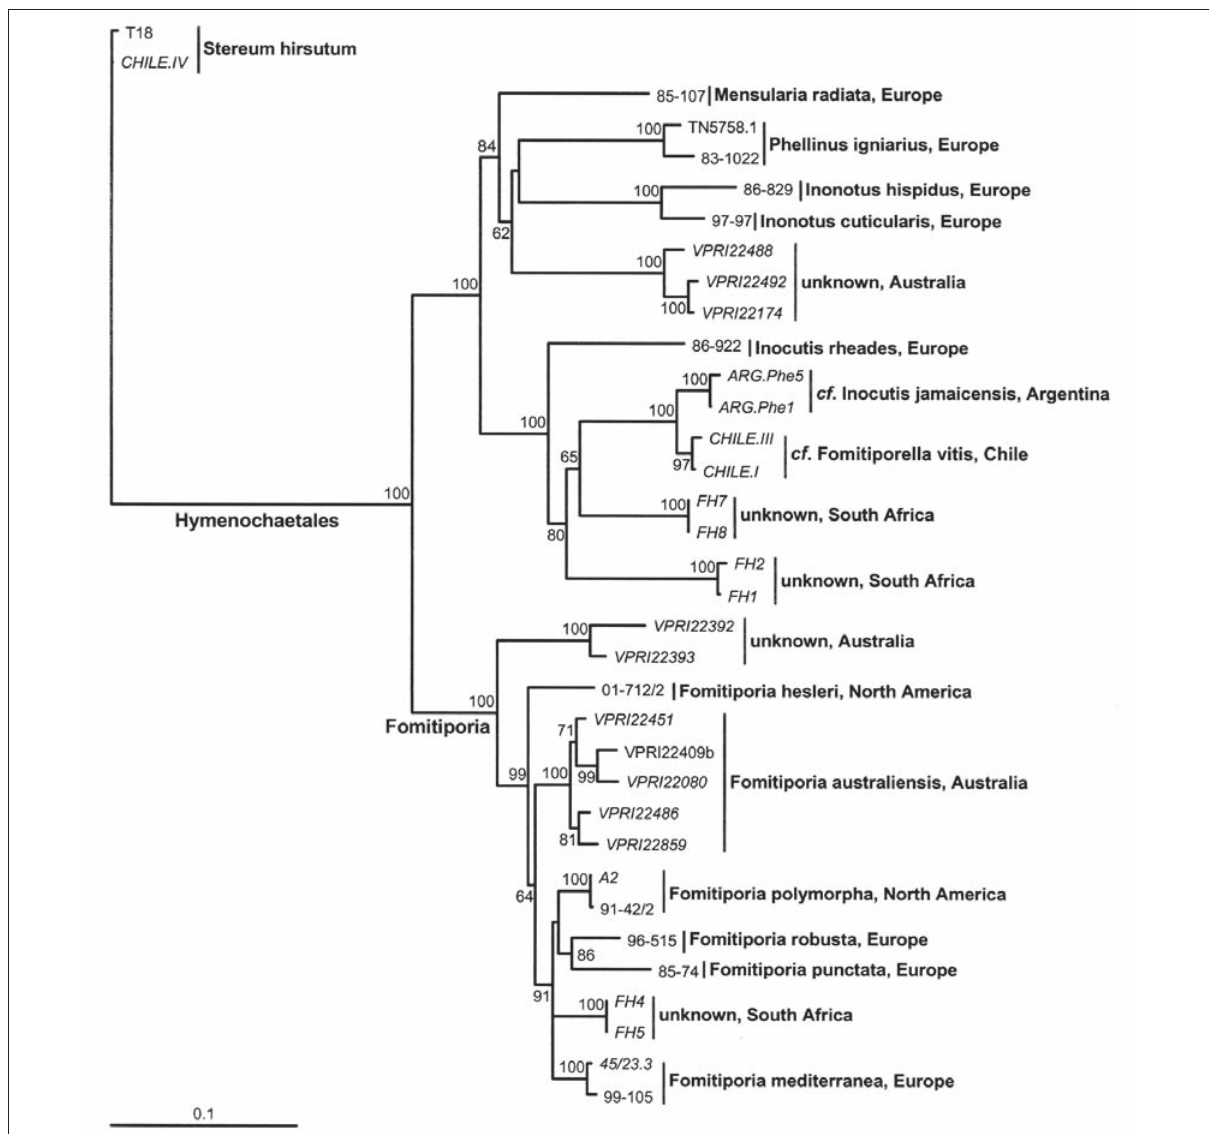
Fig. 1. Genetic diversity and phylogenetic relationships of white rot basidiomycetes on grapevine inferred from the nuclear ITS1-5.8S-ITS2 region. The tree is rooted with isolates belonging to Stereum hirsutum . Isolates in italics are derived from Vitis vinifera . The uncertain affinity of Inocutis jamaicensis and Fomitiporella vitis is explained in the